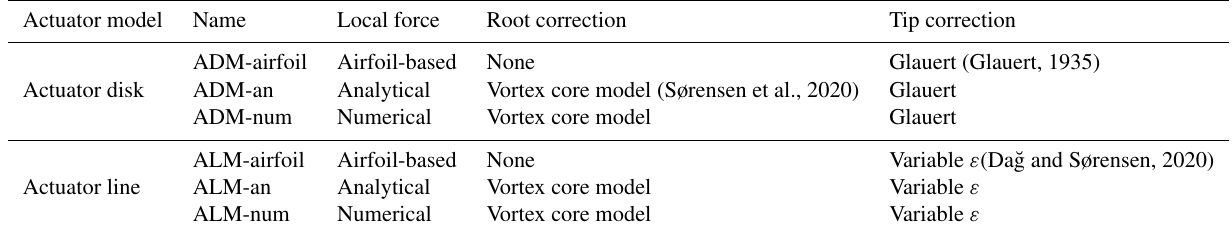
Table 1. Actuator disk and actuator line models employed in this work, describing the differences in the local force calculation and the chosen tip and root